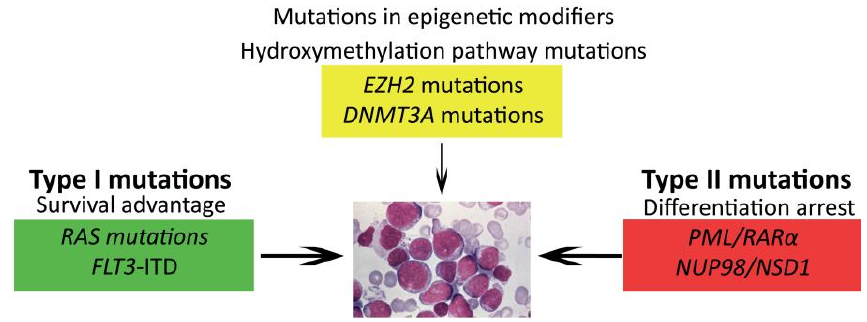
Figure 2. Model of cooperating genetic events in AML. Different types of genetic and epigenetic events collaborate in